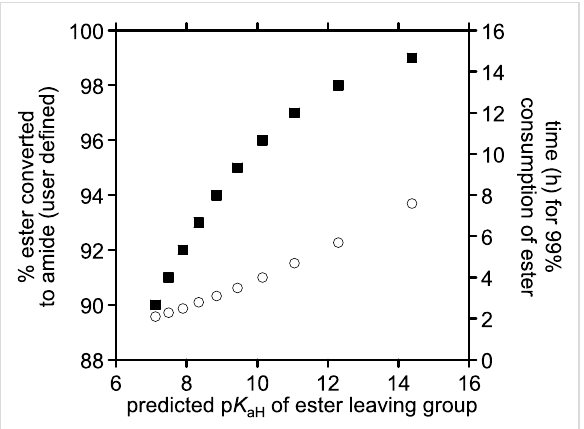
Figure 6: 2-nitrophenyl 2-(ethylthio)acetate. Whilst we have used p -nitrophenyl- and m -nitrophenyl esters, and our kinetic studies were performed at 25 °C rather than 30 °C, some analogies with the o -nitrophenyl acetate system [10] may be drawn and conclusions may be inferred on the basis of similar leaving group properties of o -nitrophenol (p K aH = 7.23 [12]). Rate coefficients for the pH-independent hydrolysis of 2-nitrophenyl 2-(ethylthio)acetate and 2-nitrophenyl acetate were reported in second order form as 1.32 × 10 − 8 M − 1 s − 1 and 1.08 × 10 − 7 M –1 s − 1 , respectively. In pseudo-first order form these coefficients translate to 4.36 × 10 − 5 min –1 and 3.56 × 10 −